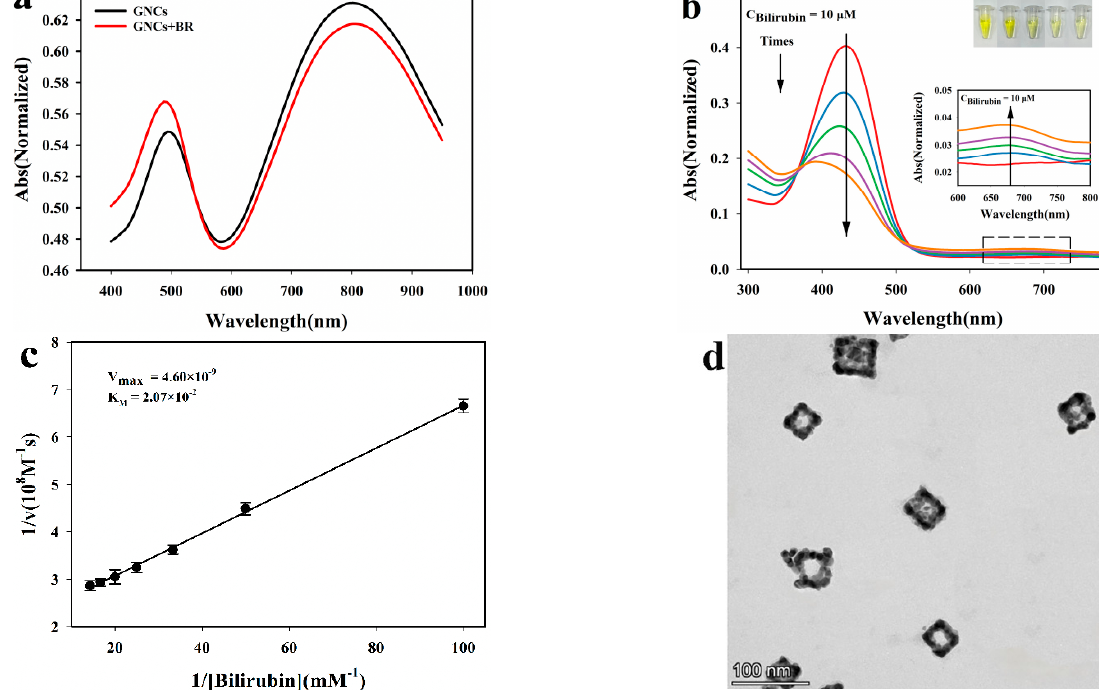
Figure 3. Absorption spectra of ( a ) GNCs solution in the absence (black line) and presence (red line) of BR, ( b ) 10 μ M bilirubin catalyzed. ( c ) the Lineweaver-Burk plots of the double reciprocal of the Michaelis-Menten equation. ( d ) TEM image of GNCs-BR solution.